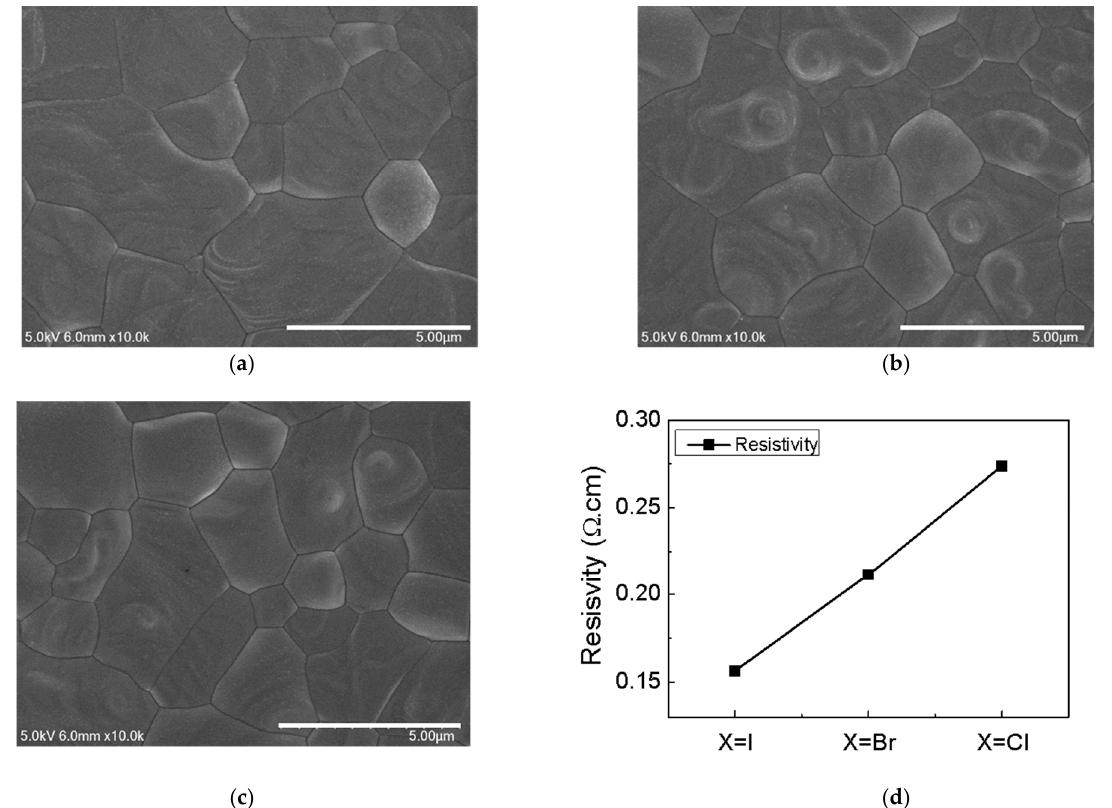
Figure 3. SEM images of the FAPbX 3 ‐ MAPbX 3 (X = I, Br, and Cl) thin film surfaces for ( a ) X = I, ( b ) X = Br, and ( c ) X = Cl, and ( d ) resistivity.